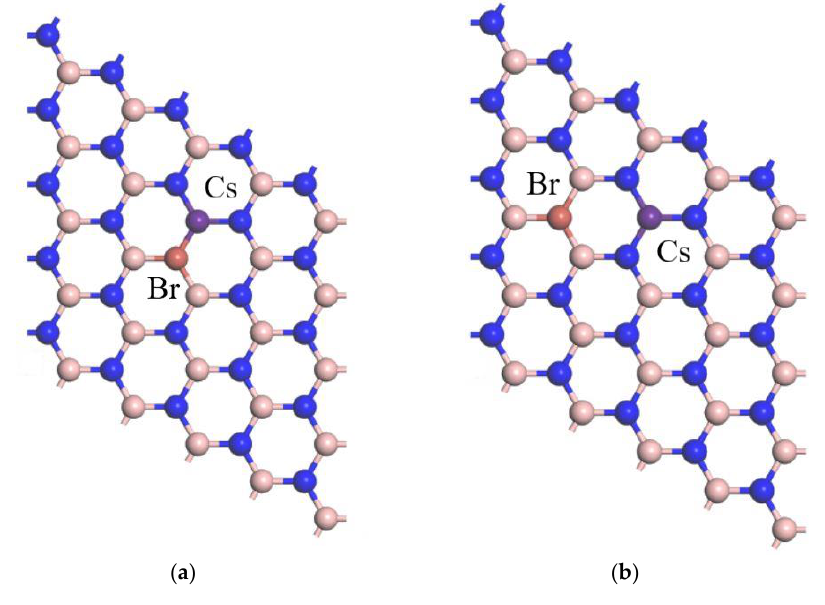
Figure 2. Model of Cs-doped ( a ) and Br-doped ( b ) h-BN.